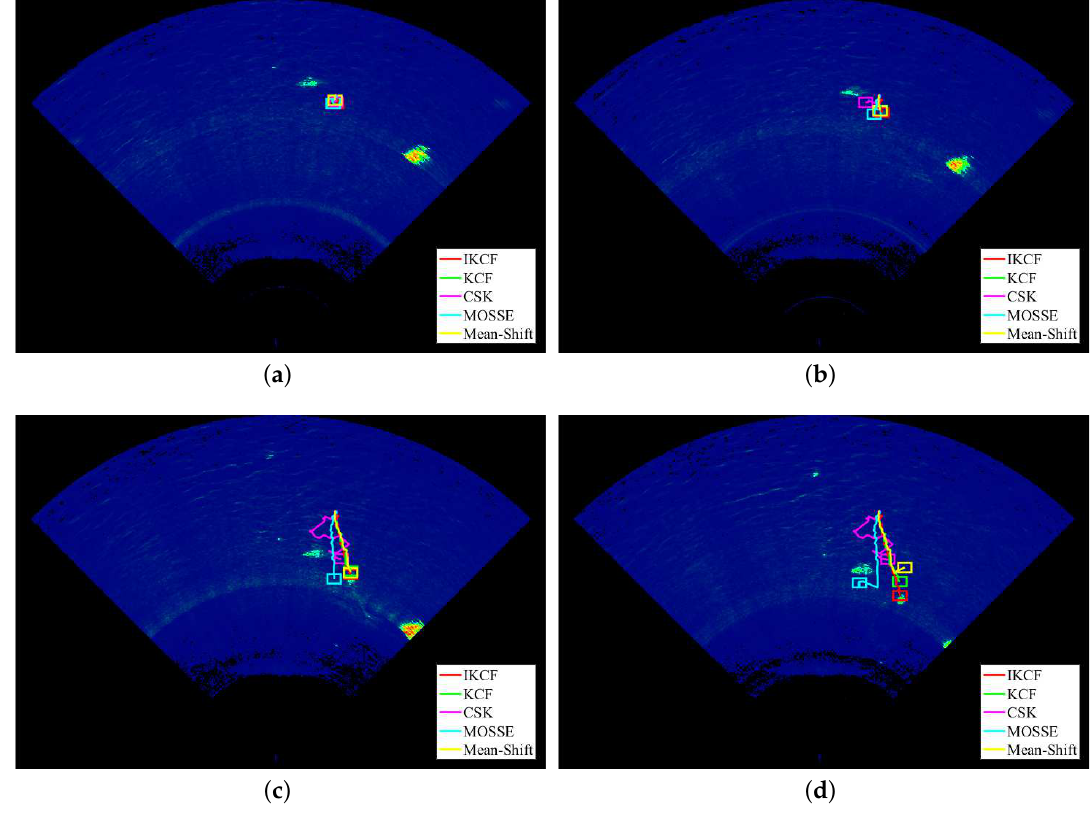
Figure 12. Tracking results for the target that disappears and appears again: ( a ) The tracking results at the 359th frame; ( b ) the tracking results at the 365th frame; ( c ) the tracking results at the 393th frame; ( d ) the tracking results at the 403rd